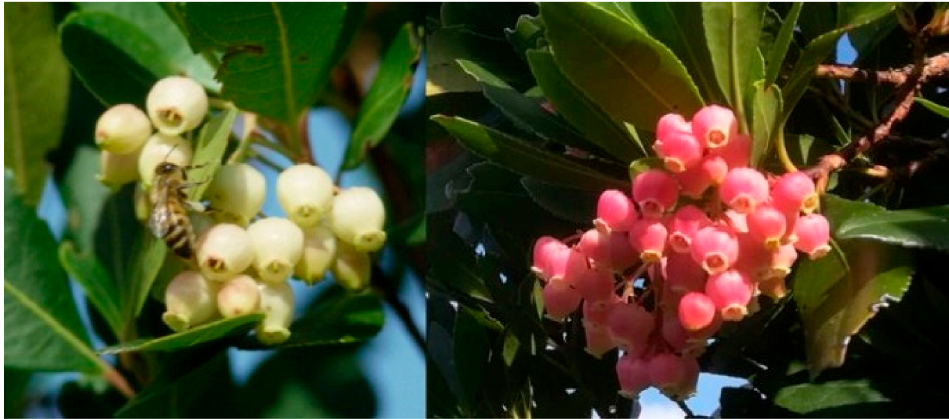
Figure 1. Strawberry tree ( Arbutus unedo L.) flowers of two distinct varieties from Sardinia (Photos: Alessandro